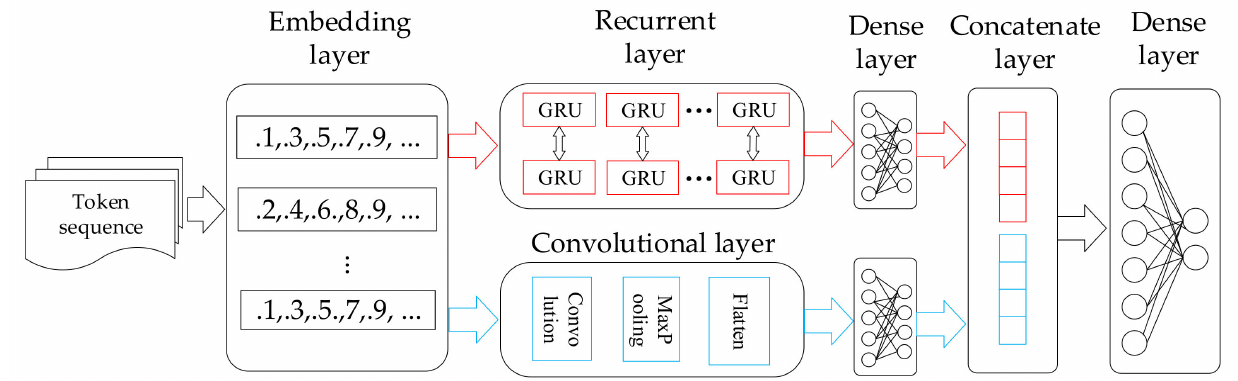
Figure 3. Overview of the proposed hybrid neural network. The input token sequence is converted into vector representation in the embedding layer. Then it is input into the recurrent layer and the convolutional layer, respectively. The red arrows represent the process of the recurrent layer, and the blue arrows represent the process of the convolutional layer. The outputs of these two layers are concatenated and feed into a dense layer to predict whether an input sample is vulnerable or